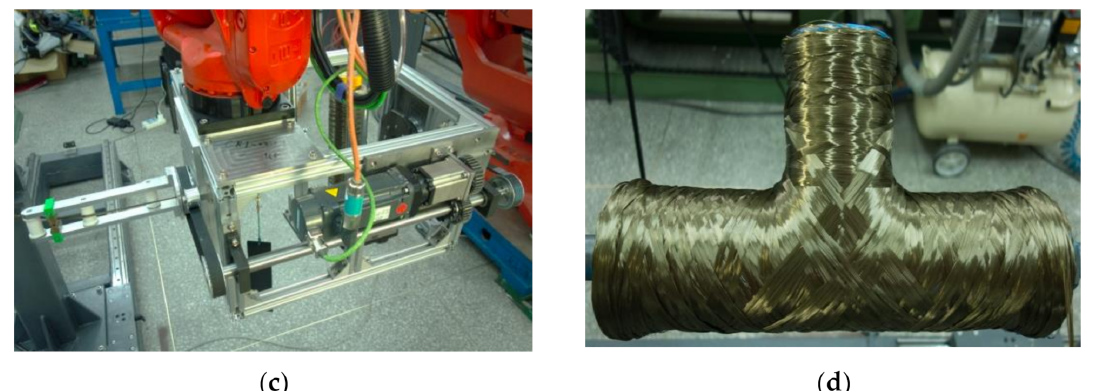
Figure 14. Six-axis robot winding system: ( a ) Winding head structure; ( b ) Six-axis robot; ( c ) Winding head; ( d ) Tee pipe after